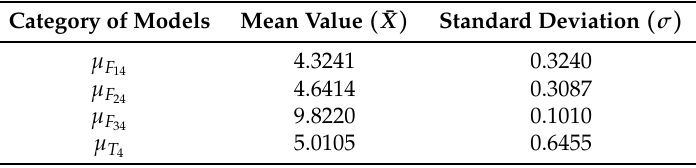
. ( a ) shows the generated fault 4 . 4 ( i = 1, 2, 3) and µ T i 4 4